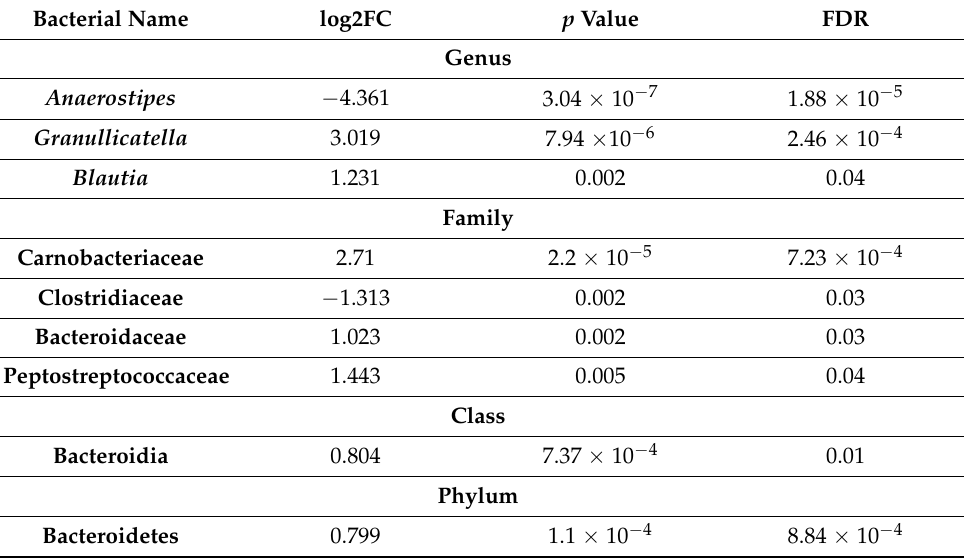
Table 5. Bacterial taxa significantly different between men who consumed less than 3 serv/d of adjusted UPF and more than 5 (from genus to phylum) analyzed by